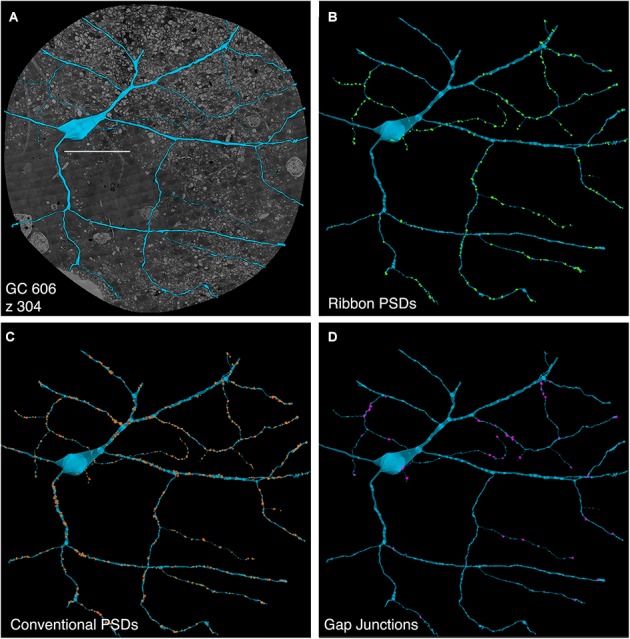
Computer rendering of GC 606 (A) superimposed on connectome slice z304 with separate displays of (B) excitatory ribbon synapse PSDs, (C) inhibitory conventional synapse PSDs and (D) 49 confirmed out of 228 identified gap junctions each displayed at 2× their true diameters. Most gap junctions are with partner GABA+ amacrine cells in Figures 9, 10. Scale, 100 μm.